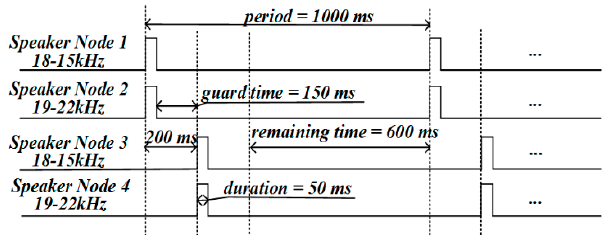
Figure 3. Waveform illustrations of chirp signals. ( a ) 18–15 kHz chirp signal; ( b ) 19–22 kHz chirp signal.